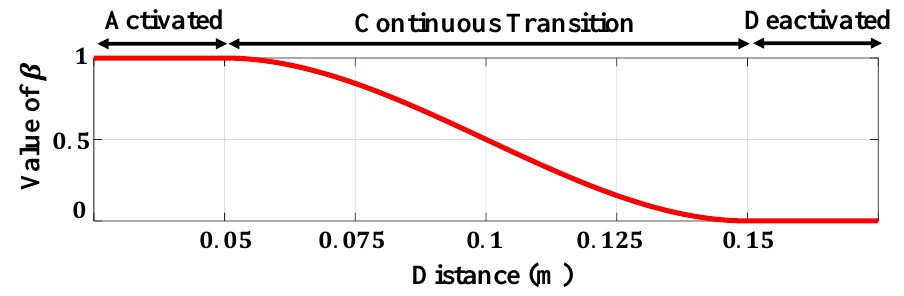
Figure 10. Value of the activation parameter depending on the distance of the link